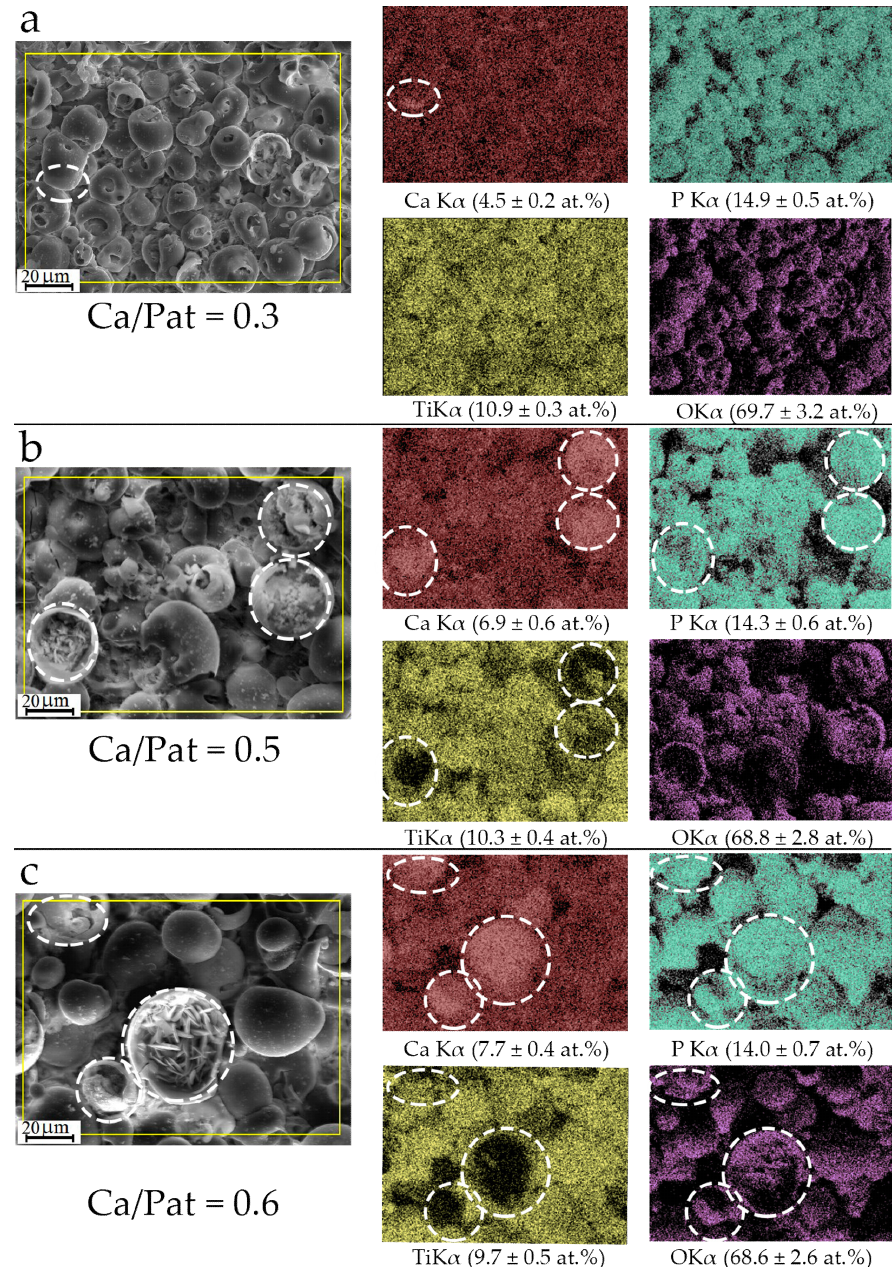
Figure 4. SEM images and EDX gray-level maps of the Ca, P, Ti, and O distributions over the surface of the CaP coatings deposited at 200 V ( a ), 250 V ( b ), and 300 V ( c ).